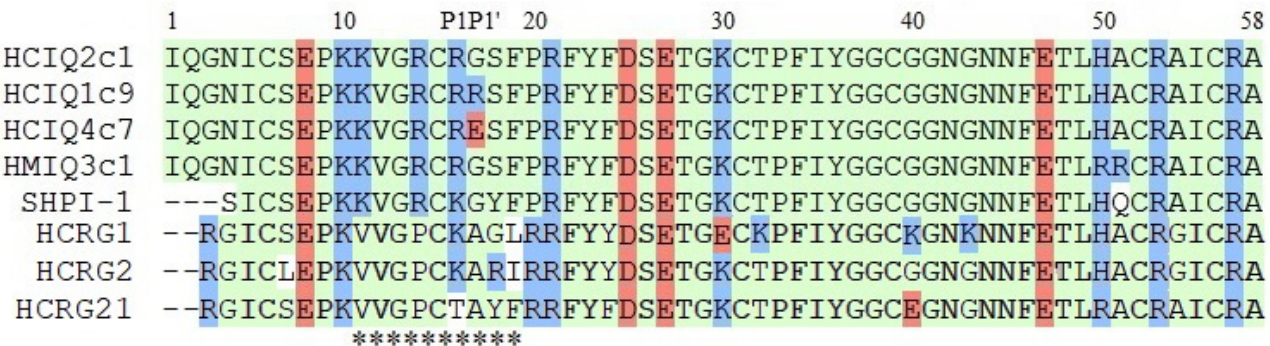
Figure 1. The alignment of sequences of peptides: HCIQ2c1 (UniProtKB ID: A0A6B7FBD3), HCIQ1c9 (A0A6B7FEJ3), HCIQ4c7 (A0A6B7FA07), HCRG1 (C0HJU6), HCRG2 (C0HJU7), and HCRG21 (P0DL86) from H. crispa ; HMIQ3c1 (A0A3G2FQK2) from H. magnifica ; and SHPI-1 (P31713) from Stichodactyla helianthus . P1-P1’—residues of the reactive sites of Kunitz-type peptides. The as- terisks (*) below the sequences indicate the contact sites with proteases. Neutral, positively charged, and negatively charged residues are colored in green, blue, and red, respectively; non-similar resi- dues are shown on white background.